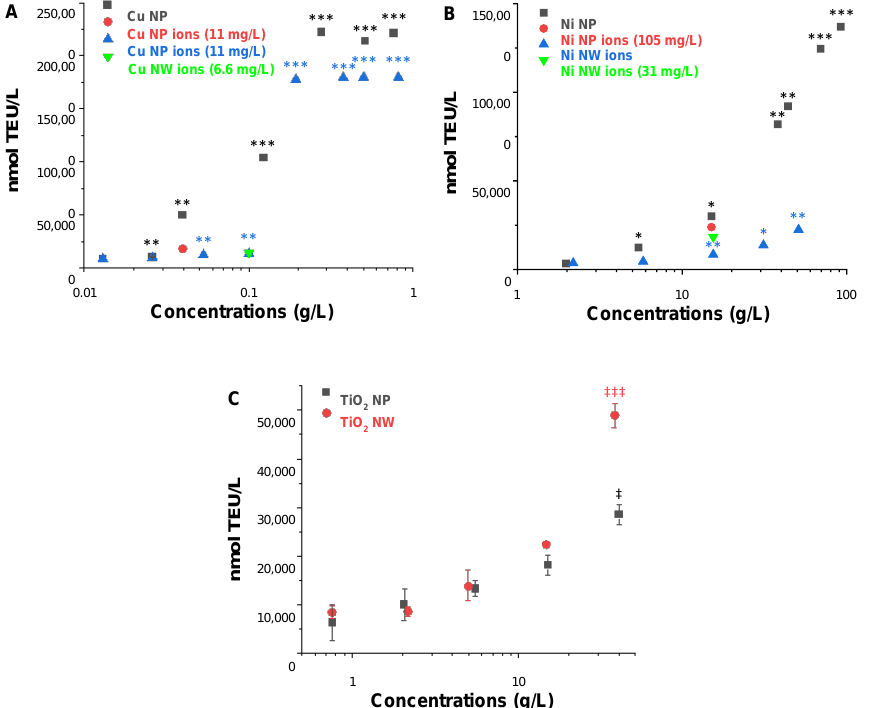
Figure 2. FRAS testing ( A ) Cu NP, Cu NP ions, Cu NW and Cu NW ions ( B ) Ni NP, Ni NP ions, Ni NW and Ni NW ions ( C ) TiO 2 NP and TiO 2 NW. Error bars indicate one standard deviation from triplicate testing, and are smaller than the size of the symbol in most cases. Statistics were performed using either ANOVA-Dunnett’s T3 (* p ≤ 0.05, ** p ≤ 0.01, *** p ≤ 0.001) or the 2-sided Dunnett’s test (‡ p ≤ 0.05, ‡‡‡ p ≤ 0.001 ).